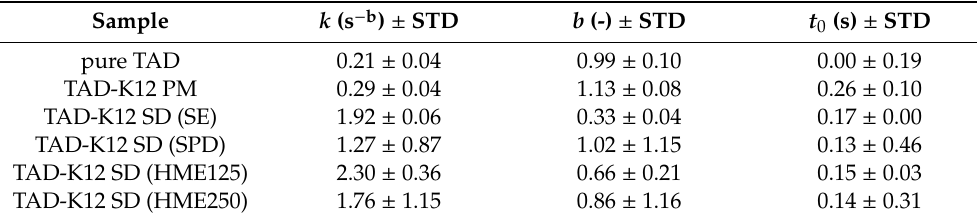
Table 3. Kinetic parameters of TAD release (K12 polymer matrix).